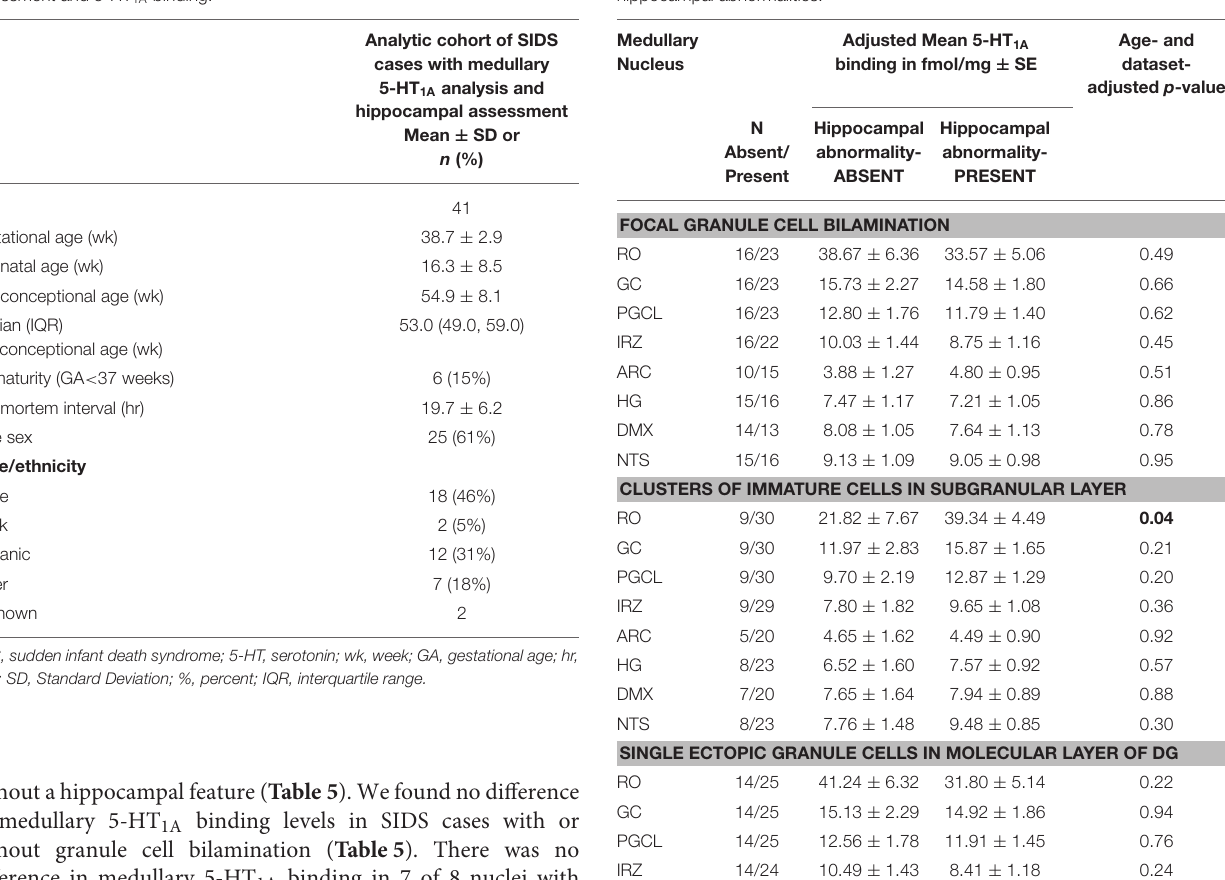
TABLE 4 | Demographics of the SIDS analytic cohort with hippocampal assessment and 5-HT 1A binding.